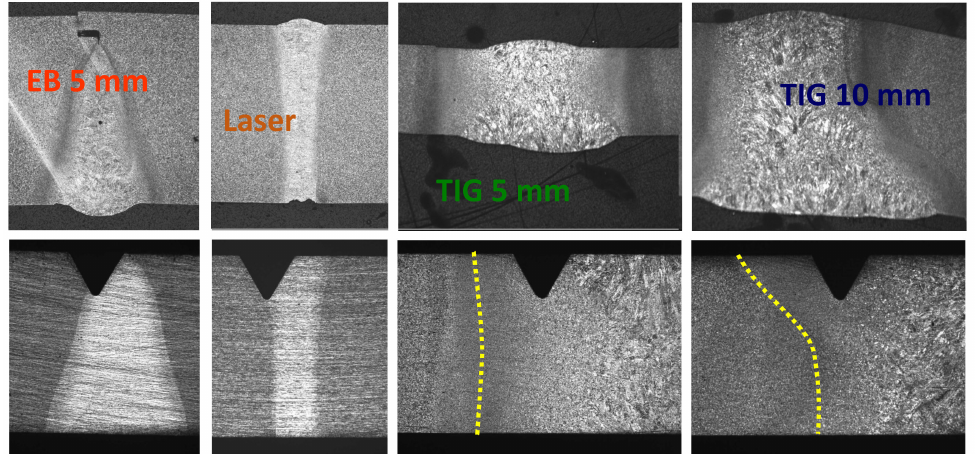
Figure 9. ( Upper row ) Cross-sections of 5 mm electron beam (EB) weld with beam stopper, 5 mm laser weld with beam stopper, 5 mm and 10 mm 1 -V tungsten inert gas (TIG) weld; ( lower row ) the 2 alignment of the notch of the Charpy specimens in the heat affected zone (HAZ). The dotted lines indicate the course of the softest area within the HAZ in the TIG